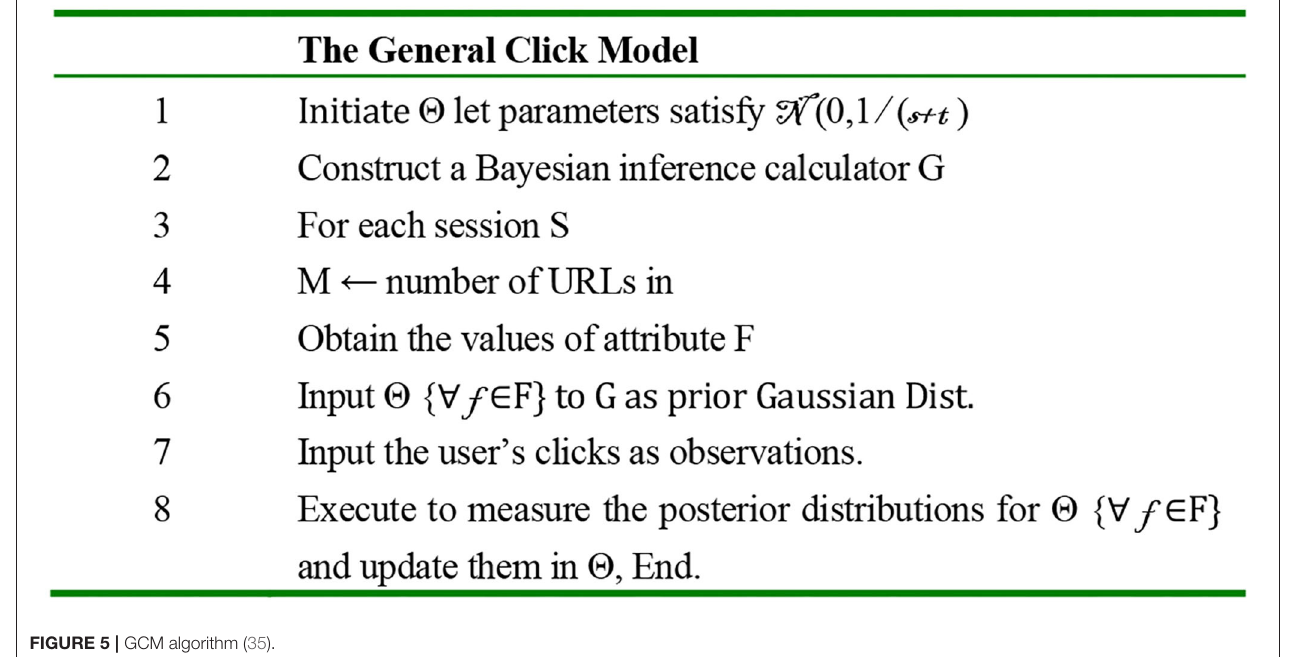
FIGURE 5 | GCM algorithm (35).